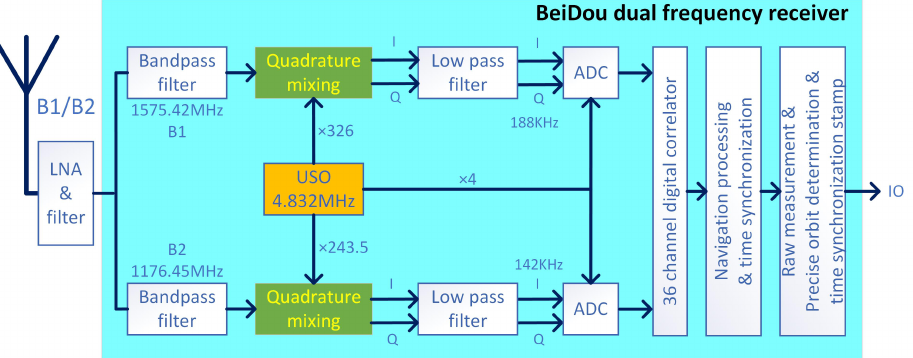
Figure 5. Structure diagram of the dual frequency receiver, including the B1/B2 signals bandpass, quadrature mixing, low pass filter, ADC and the signal process